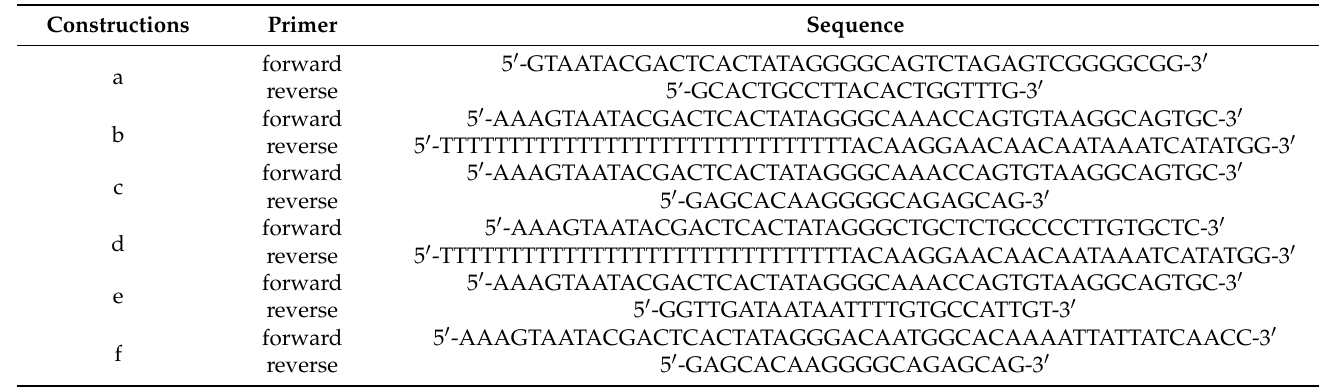
Table 2. Constructions 3 (cid:48) UTR